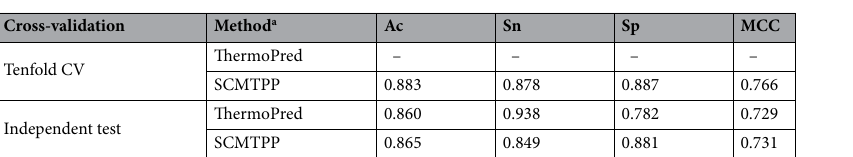
Table 5. Cross-validation and independent test results of SCMTPP and ThermoPred. a Results were obtained by feeding the protein sequences in the independent validation set to the web servers of